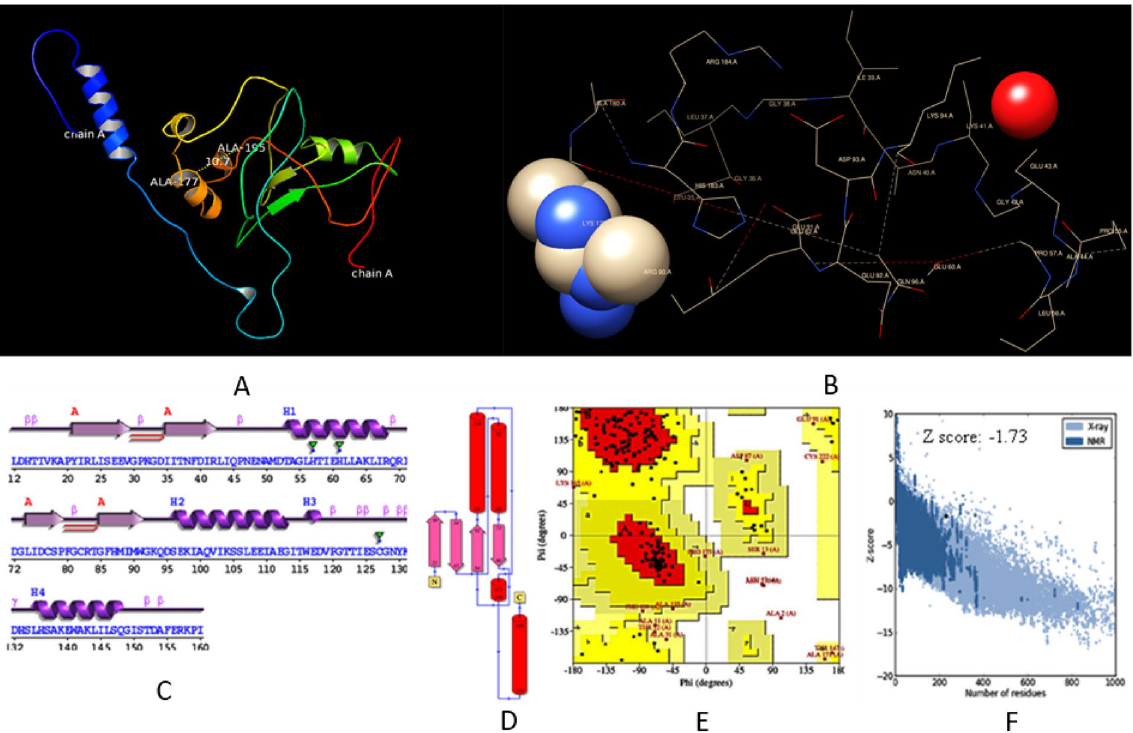
Figure 3. Tertiary structure of TaTIFY 1 gene ( A ) showing a single chain of 231 amino acid having active site between Ala 117 and Ala 195 with atomic distance 10.7 Å. ( B ) Detailed structure of TaTIFY1 transcription factor showing major DNA binding site (Volume—2497.02 [Å 3 ], Surface—3516.88 [Å 2 ], Lipo surface—2343.34 [Å 2 ], Depth—26.66 0.68[Å] Simple Score—0.68). Validation of stereo-chemical property of the tertiary structure of TaTIFY1 through ( C ). PDBsum server secondary structure, ( D ) wiring diagram, ( E ) Ramachandran plot, ( F ) ProSA web